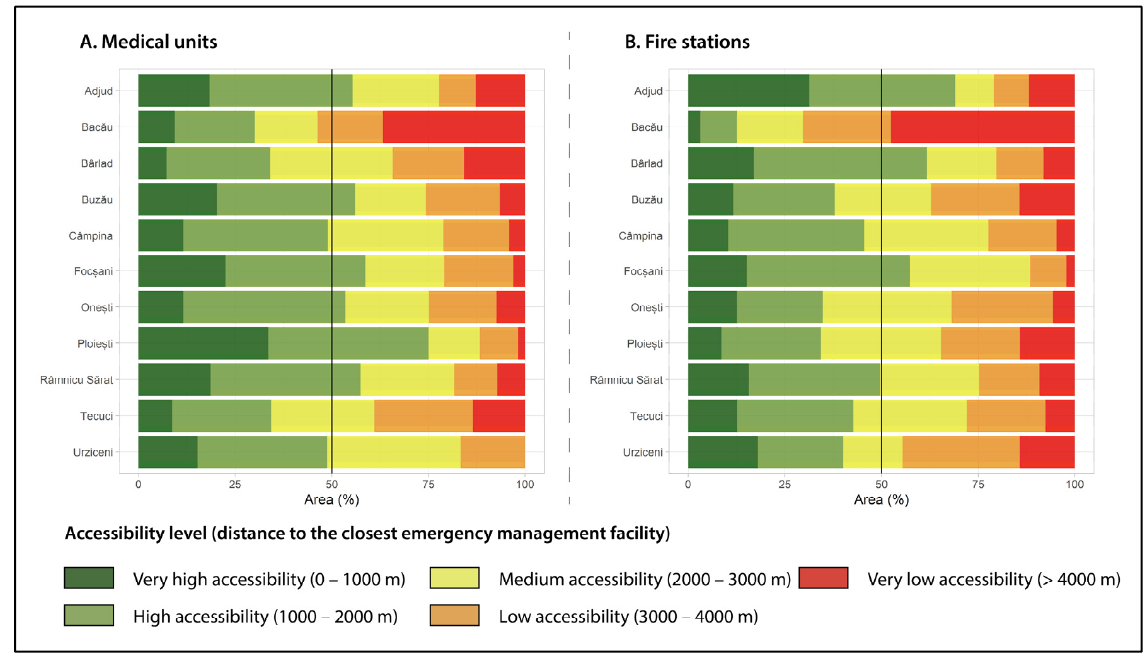
Figure 4. Areas (as percentage of urban territory) of accessibility levels and distance-based polygons to the ( A ). medical units, ( B ). fire stations, in the 11 urban settlements.